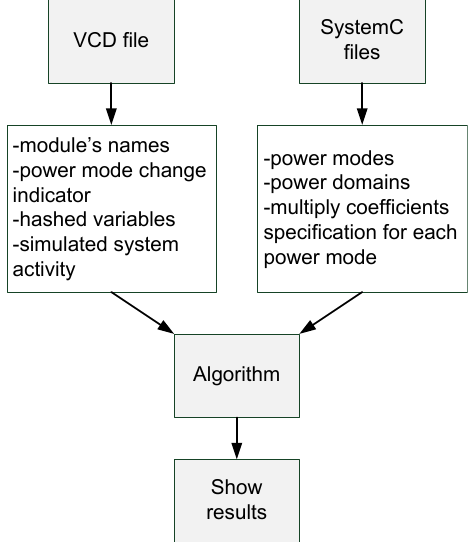
Figure 1. Process data flow in the proposed